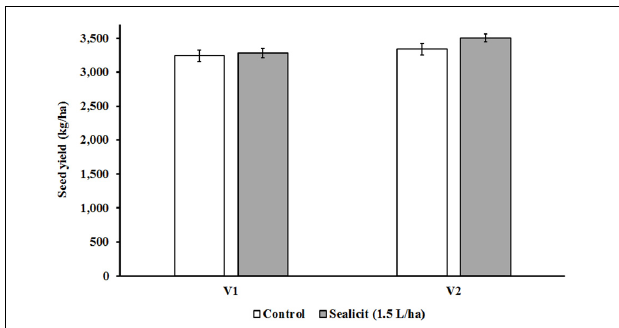
FIGURE 1 | Effects of Sealicit TM on seed yield in two commercial soybean varieties with glyphosate herbicide resistance. Sealicit TM was applied by foliar spray (1.5 L/ha) at vegetative stage (V2–V3), and its performance was benchmarked against untreated plants. Field trials with V1 and V2 were carried out in Minto (ON, Canada) and Elm Creek (MB, Canada) in 2017 under standard grower practice, respectively. Each bar represents seed yield (kg/ha). Number of biological replicates ( n = 4).